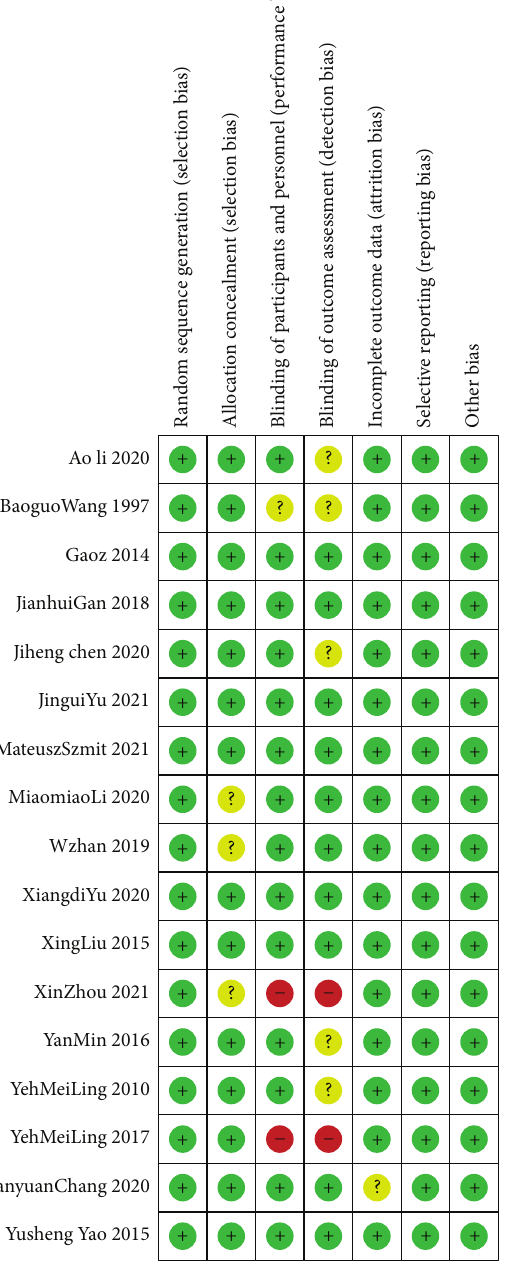
Figure 2: Potential risk of bias of each included study. Note. “+” represents low risk; “?” represents unclear risk; and “-” represents high